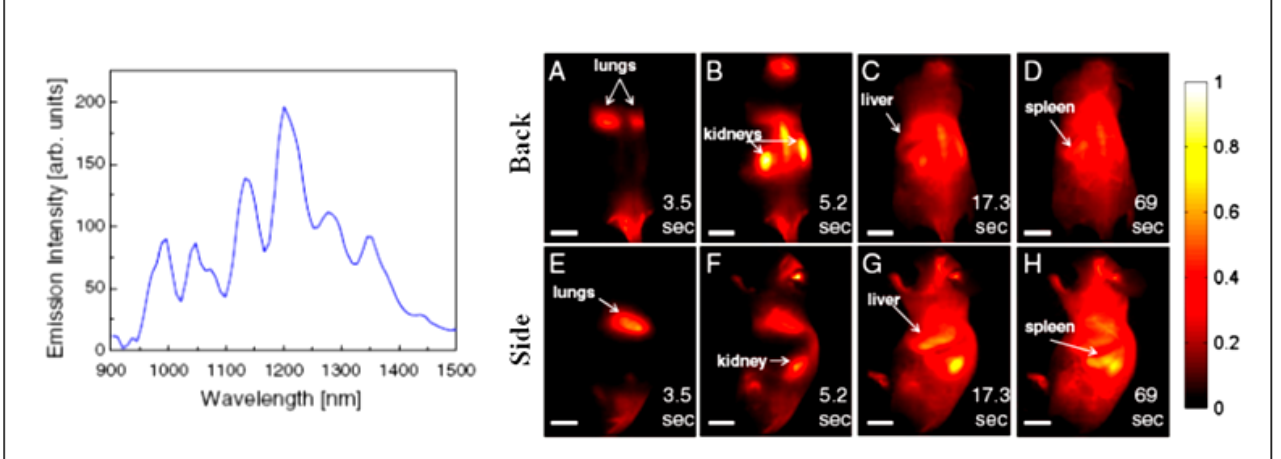
Figure 8. Left panel : Fluorescence spectrum of DSPE-mPEG functionalized SWNTs excited at 808 nm, showing several emission peaks in the NIR II ranging from 1000–1400 nm. Right panel : Frames from video imaging of mice injected with SWNTs. At 3.5 s ( A and E ) post tail-vein injection, the lungs are the dominant feature, corresponding to flow of oxygen-poor, SWNT-rich blood to the lungs. At 5.3 s ( B and F ), the SWNT-rich blood flows through the highly vascularized kidney followed by the liver at 17.3 s ( C and G ) and the spleen at 69 s ( D and H ). (Reprinted with permission from [134], copyright 2011